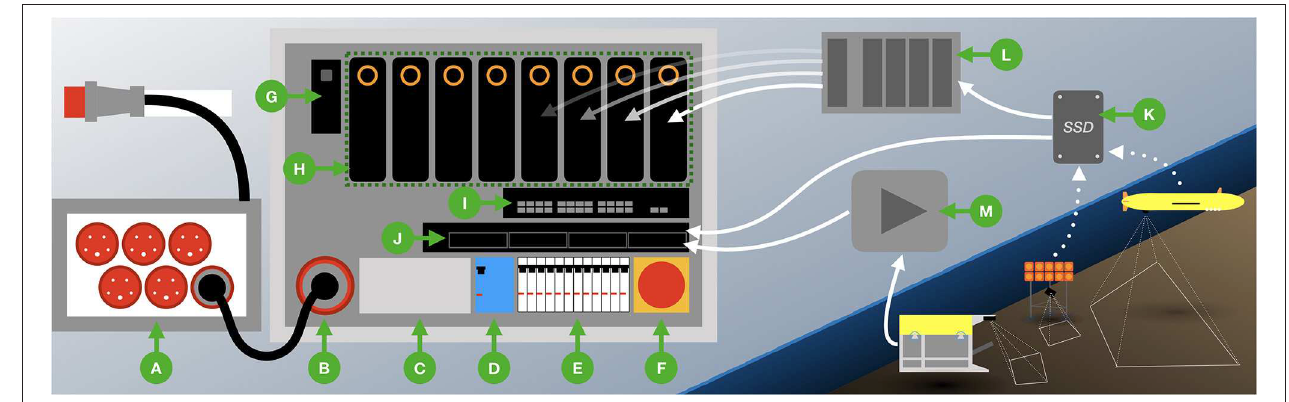
FIGURE 1 | Depiction of a SHiPCC unit setup (B–J) and its power (A) and data (K–M) supply. A power distribution box (A) , capable of providing energy to six SHiPCC units, connects to the ship’s power grid and converts from 63A to 32A (400V). Each cluster unit has a 32A input (B) , a filter to smooth the provided current (C) an FI fuse (D) , several independent fuses for the compute components (E) and an emergency off-switch (F) . Thus the control computer (G) , the eight compute nodes conducting the actual computation with their eight individual GPUs and four CPU cores (H) , the network switch (I) and the NAS (J) can be powered securely from the research vessel’s main power grid. Data from untethered gear like AUVs or landers is retrieved by data medium (K) . This data can either be directly transferred to the NAS or be multiplied by an external data duplication device (L) . Multiplied data on several independent media can be connected to the compute